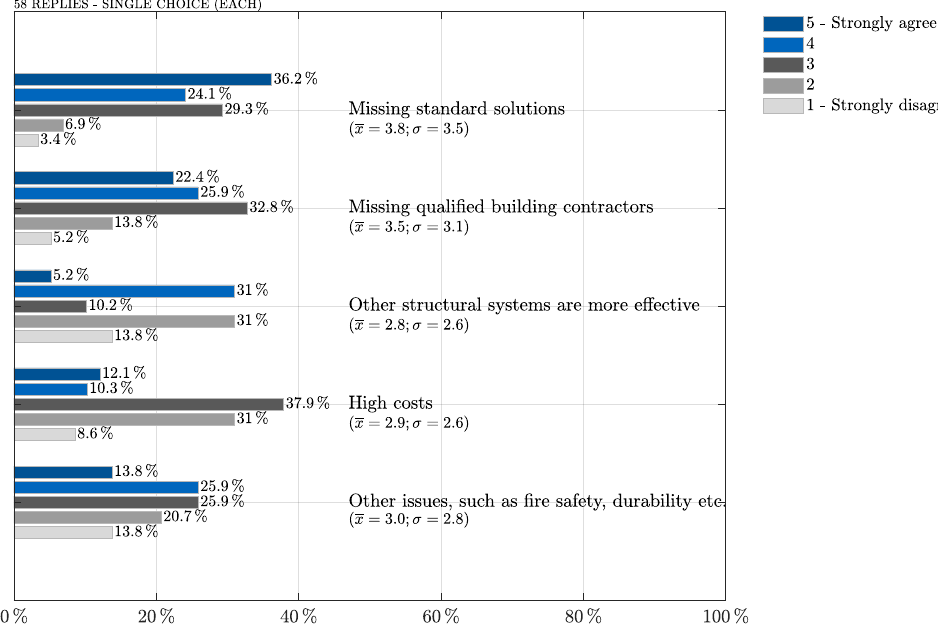
Figure 19. Reasons why CLT or hybrid (CLT-concrete) structures are not commonly used for high-rise buildings in seismically active